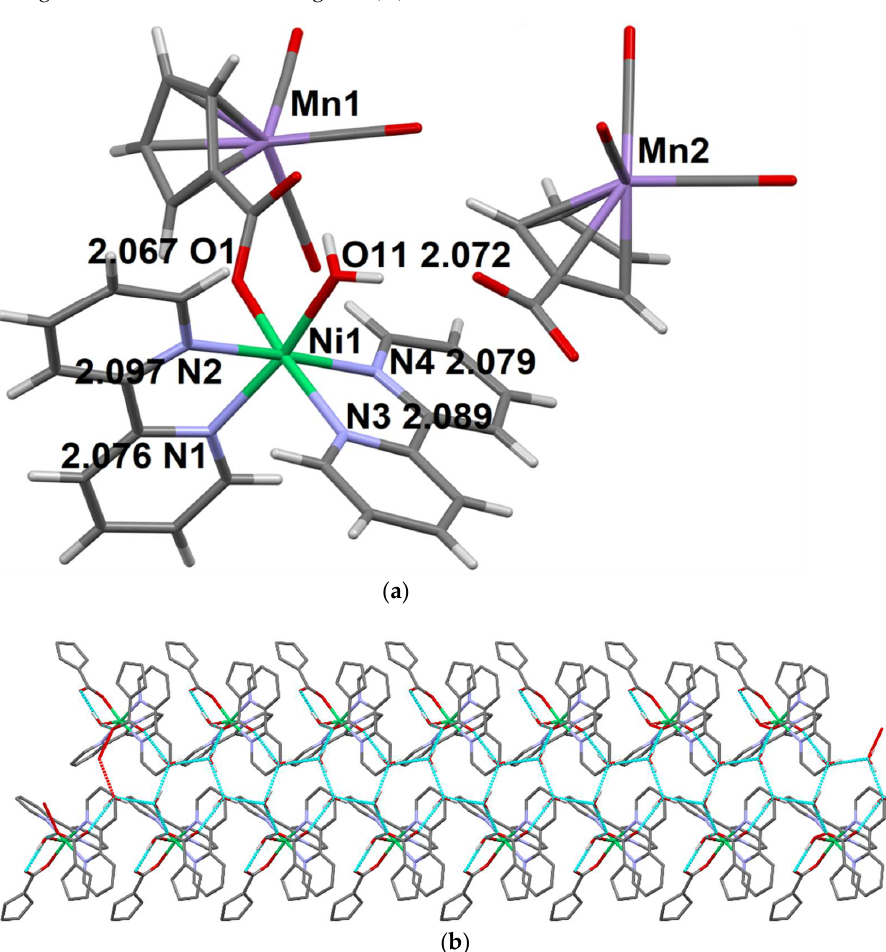
Figure 3. The structure of complex molecule in 5 . The distances between the coordinating atoms of the ligands and the Co 2+ ion are given (Å).